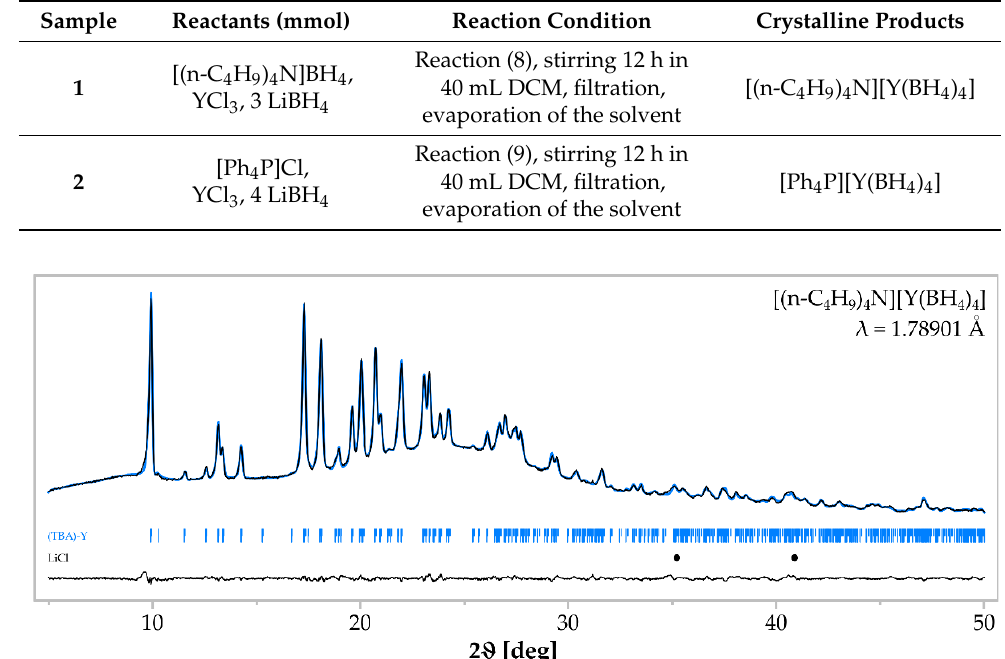
Table 1. Reactions performed using a new method of synthesis of an organic derivative of metal borohydrides: samples names, reactants used, reaction conditions and crystalline products obtained.